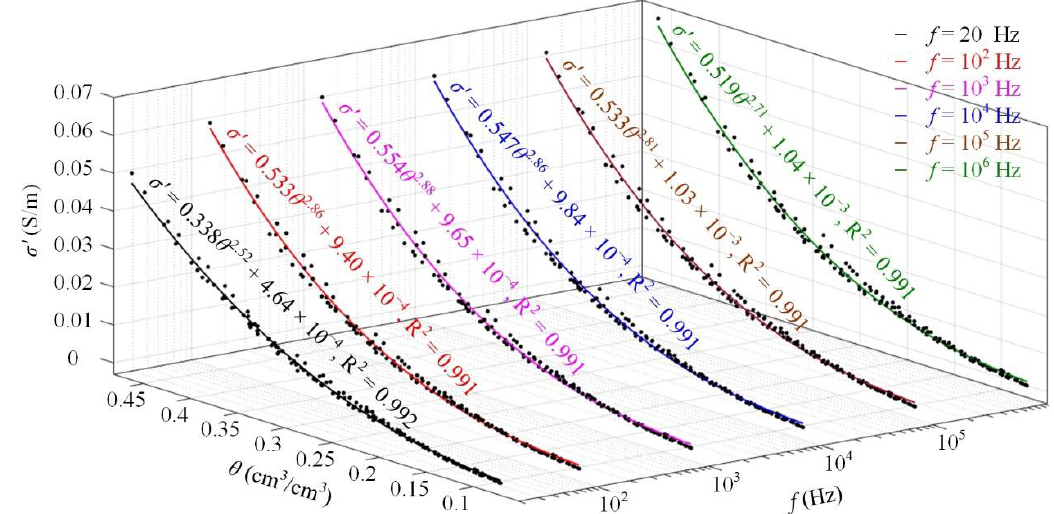
Figure 10. Fitted relations between in-phase substrate conductivity and volumetric water content at different frequencies for the substrates with certain variability in dry density. The mean and standard deviation of the dry densities (Table S1) are 0.455 g/cm 3 and 5.04 × 10 − 2 ,